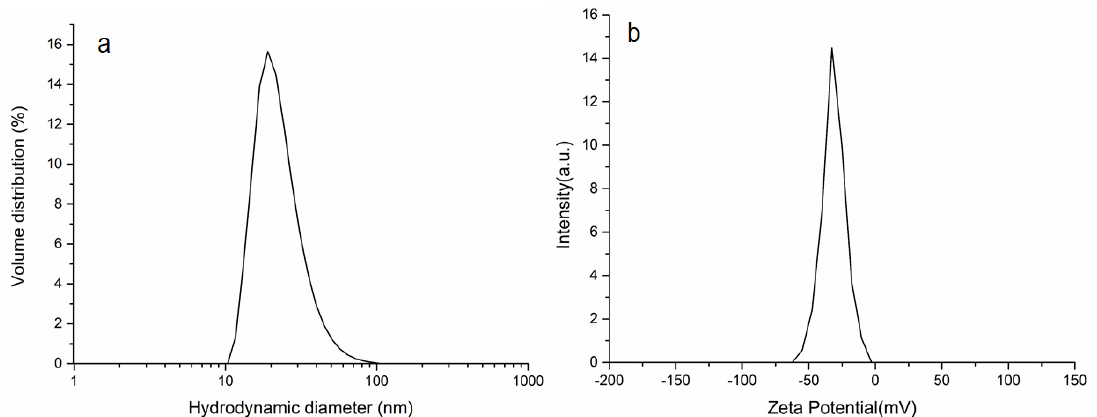
Figure 7. Hydrodynamic diameter, D h , distribution by volume ( a ) and ζ -potential ( b ) of 25MgHAp nanoparticles in suspension.